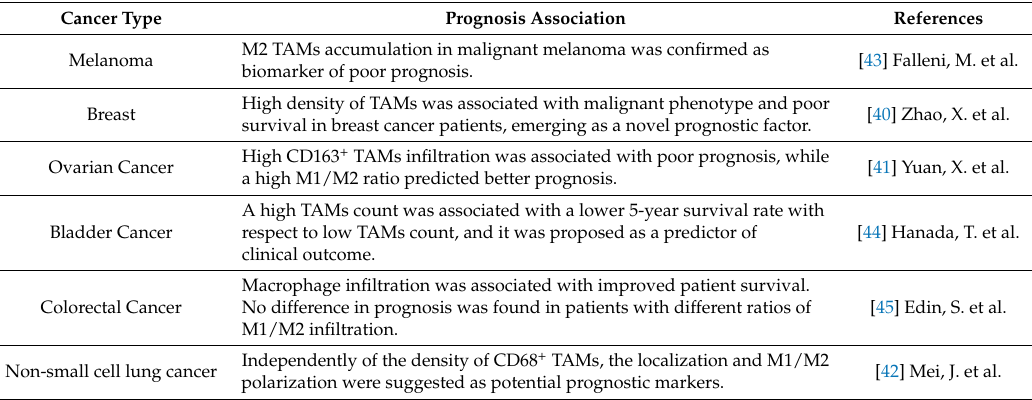
Table 1. Prognostic significance of macrophages in tumors. TAMs: tumor-associated macrophages, M1:pro-inflammatory, M2: